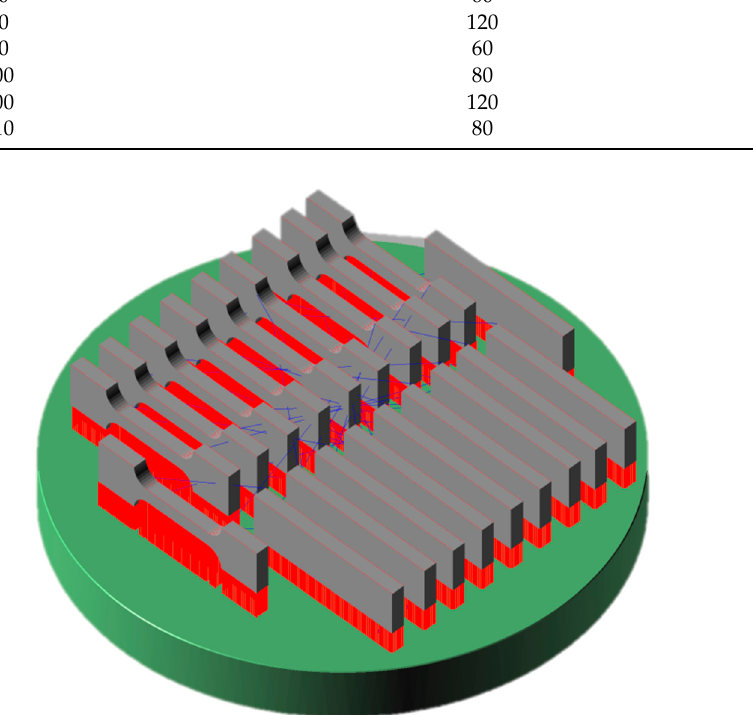
Figure 5. Example of product placement on the working platform (supports marked as red).